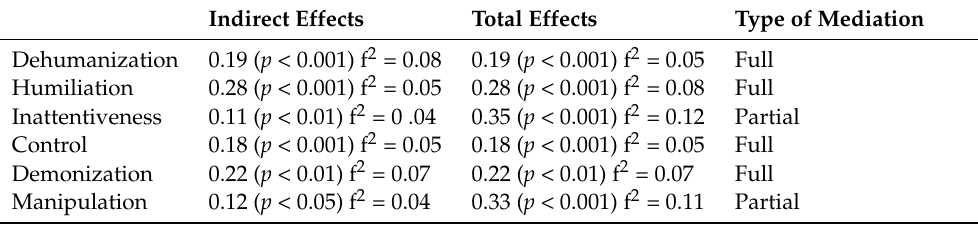
Table 3. Mediation tests (Organizational Barriers -> Patient as Obstacle -> Dignity